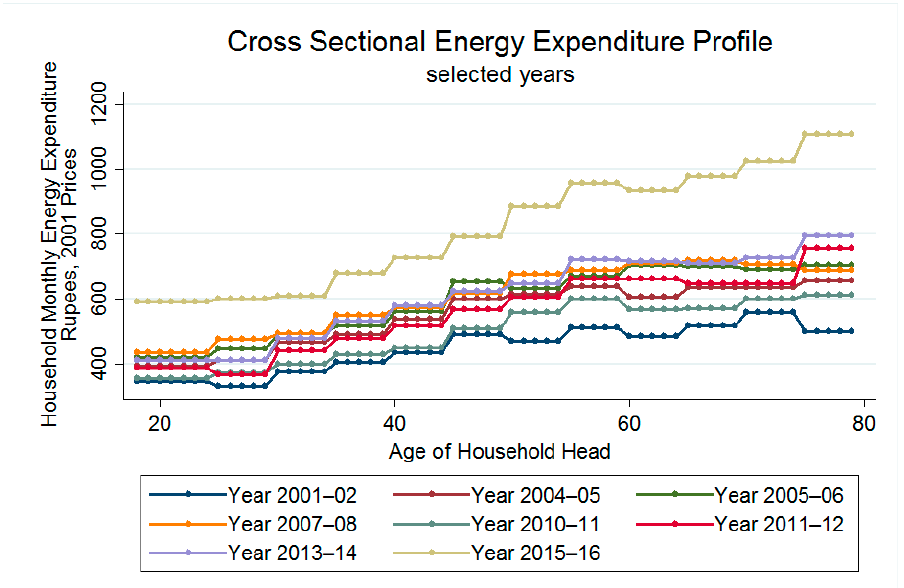
Figure 3. Cross Sectional Energy Expenditure Profile.